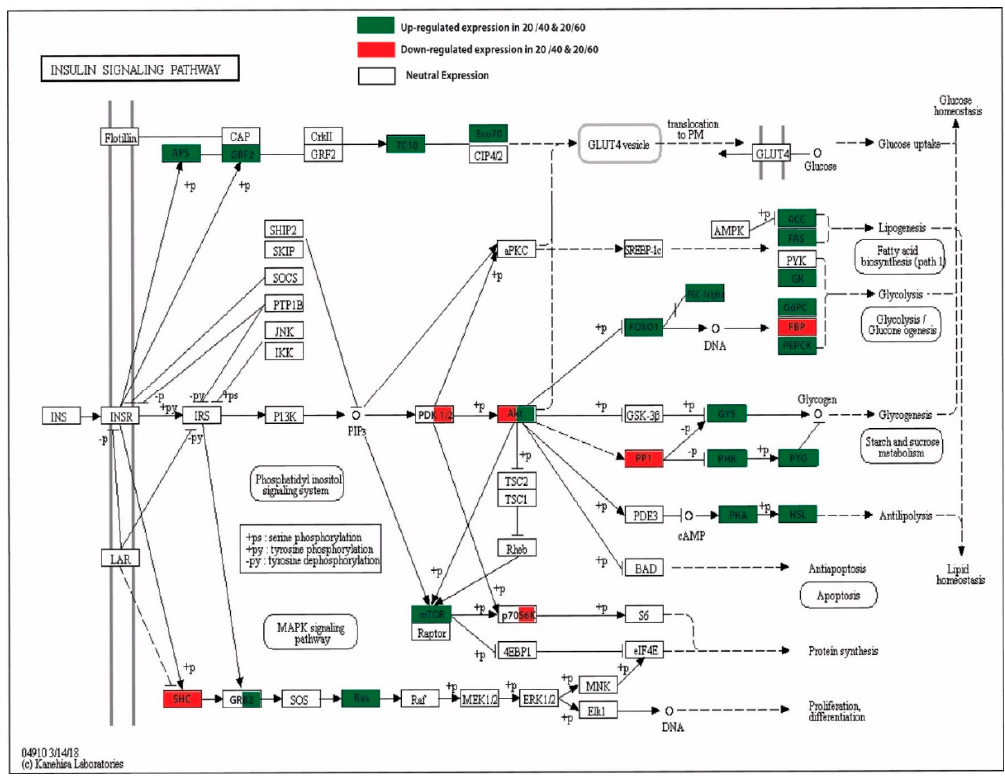
Figure 7. Insulin signaling pathway. Key components of pathways are depicted, red indicates down ‐ regulation, green indicates up ‐ regulation and black indicates neutral regulation of key genes/enzymes.